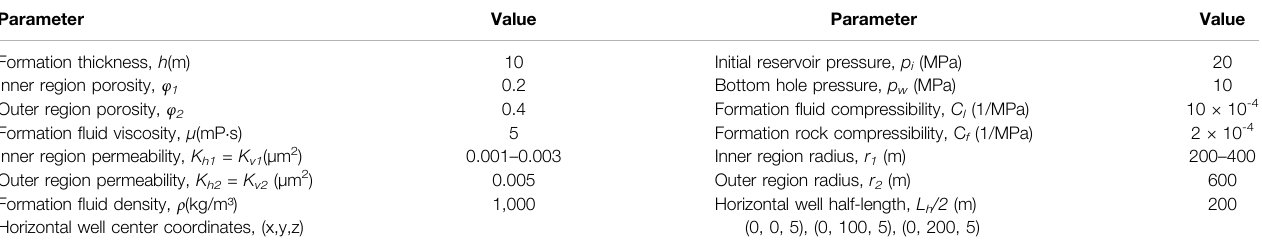
TABLE 1 | Input parameters for horizontal well entirely in the inner region.